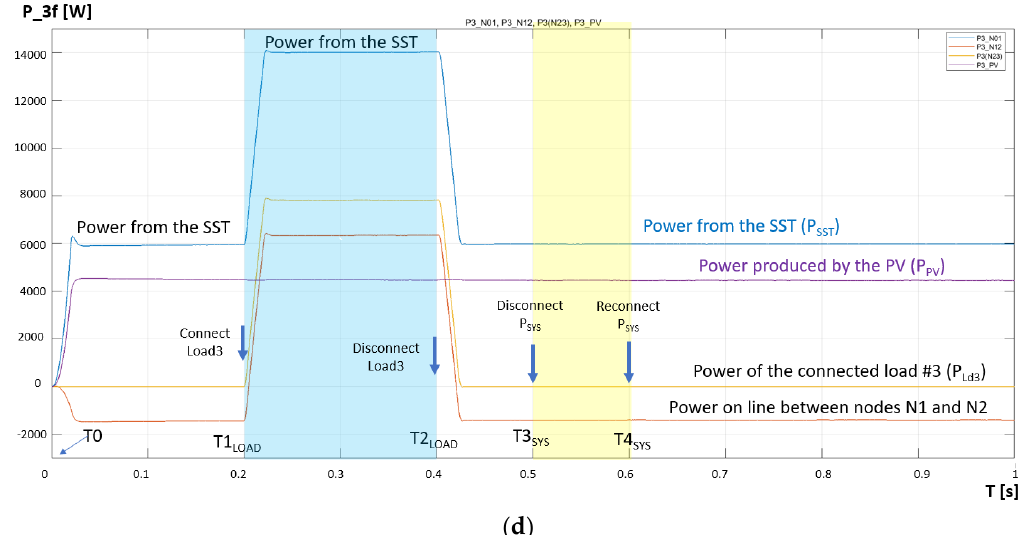
Figure 8. Simulations results in Scenario 1. ( a ) DC bus voltage in the SST; ( b ) Current injected from the main grid in the DC bus of the SST; ( c ) The output currents of the SST (ISST), injected into the microgrid; ( d ) Active power evolution in different parts of the AC microgrid.